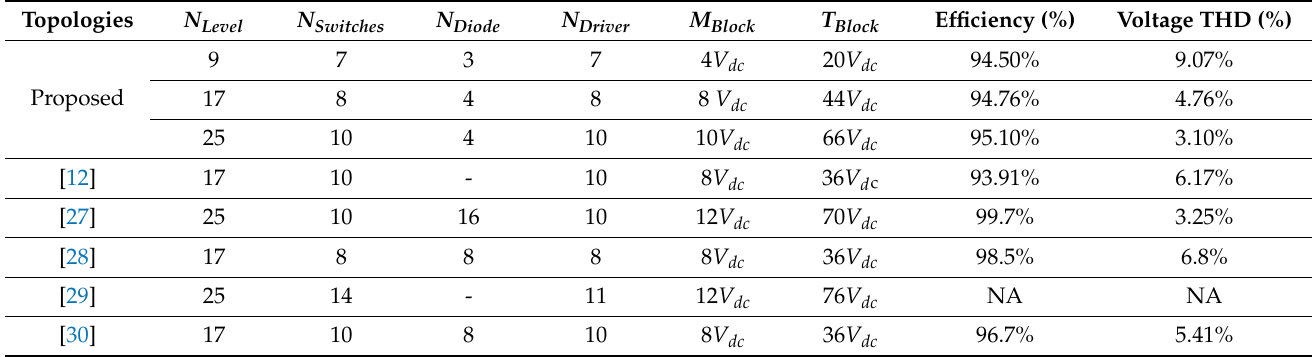
Table 4. Comparison of proposed topology and other recent MLI topologies